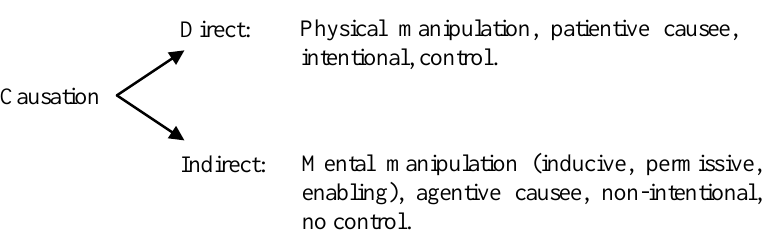
Figure 3. Direct and indirect